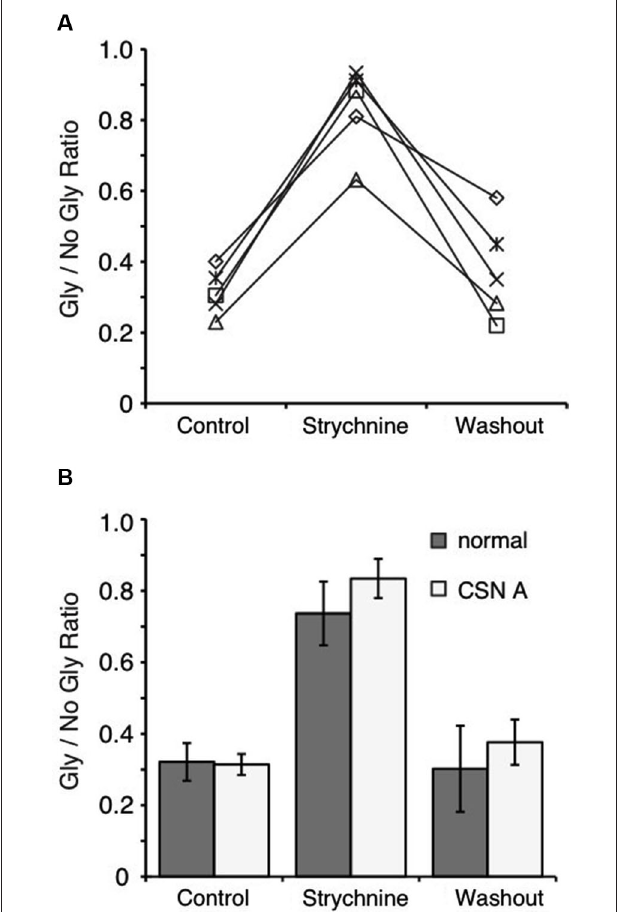
FIGURE 4 | Blocking phosphatase 2B activity does not affect suppression in the NM. (A) Ratio of peak amplitude between Gly/no Gly in each condition reveals that inclusion of cyclosporin A in the recording pipette does not prevent suppression. (B) Population data comparing the results using internal solution with cyclosporin A (CSN A) and the normal internal ( Figure 2C ). Phosphatase 2B activity does not play a role in the observed